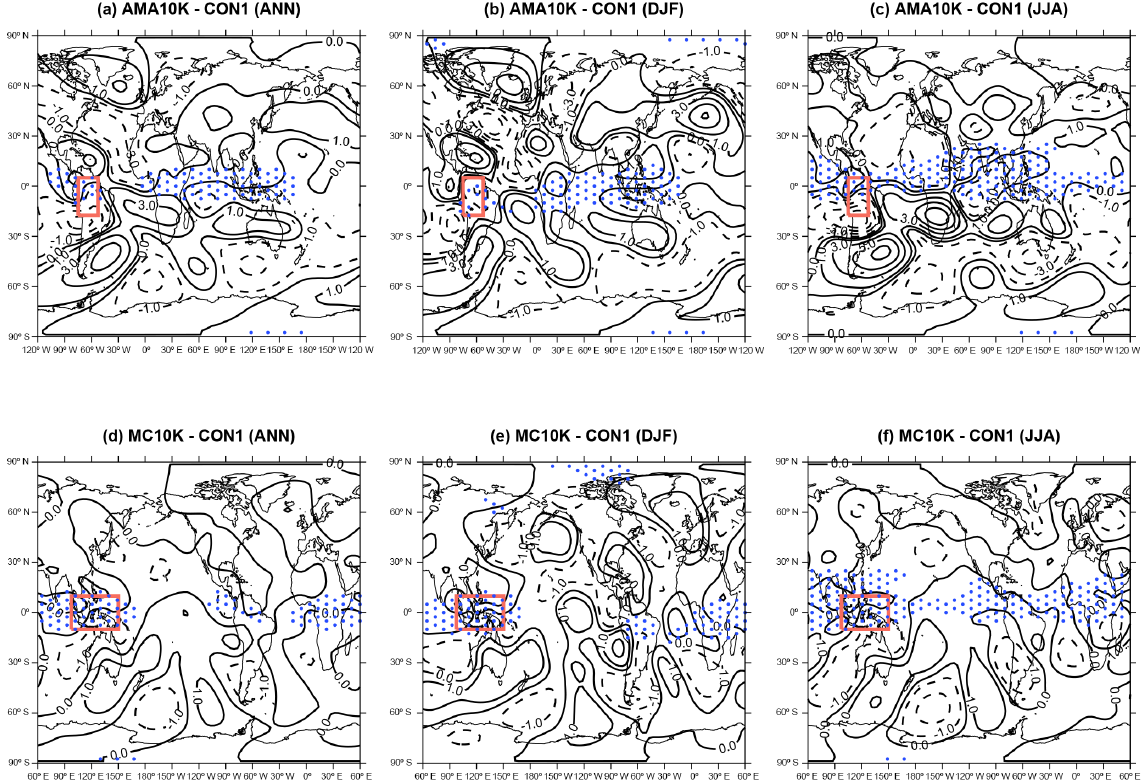
Figure 9. Differences in the deviation of the zonal mean streamfunction at 300hPa between AMA10K and CON1 for (a) annual mean, (b) DJF mean, and (c) JJA mean, and between MC10K and CON1 for (d) annual mean, (e) DJF mean, and (f) JJA mean (contours). Orange boxes indicate the area where the land surface temperatures were increased by 10K in AMA10K (top row) and MC10K (bottom row). Grid points where the mean background zonal flow is easterly are stippled in